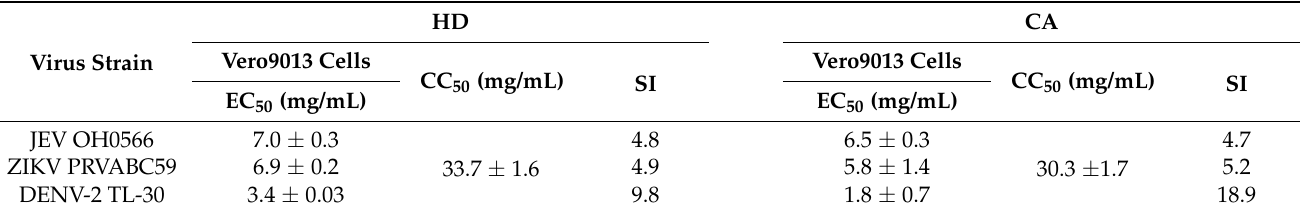
Table 1. Representation of the antiviral activities of HD and AC by SI *.